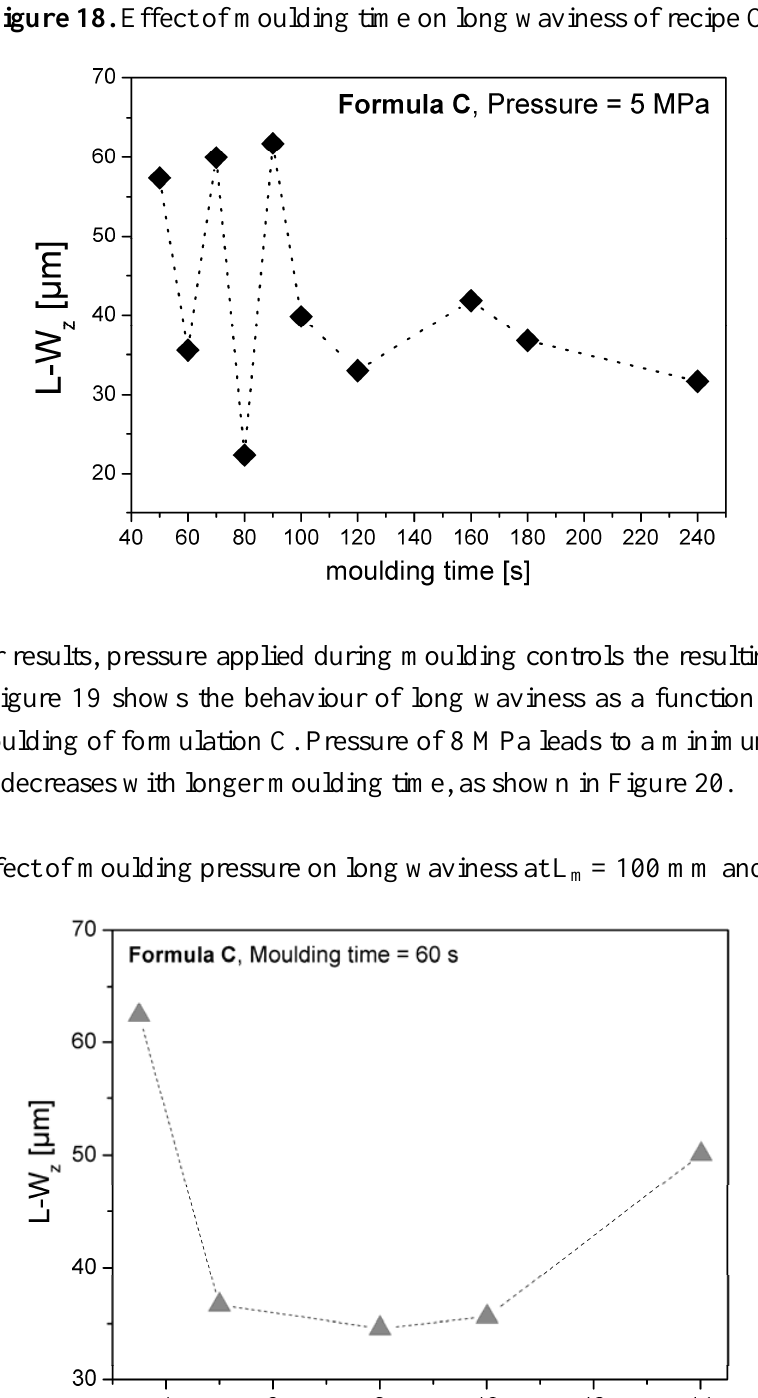
Figure 18. Effect of moulding time on long waviness of recipe C.